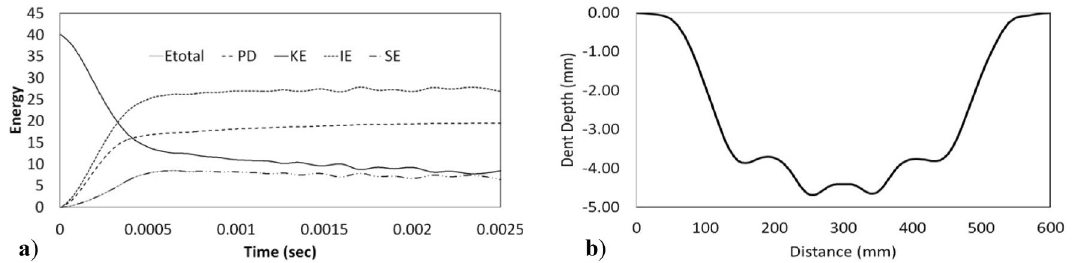
Figure 9. Results of the FE model for specimen 50-15-1: ( a ) energy history and ( b ) permanent distortion (springback modeling).